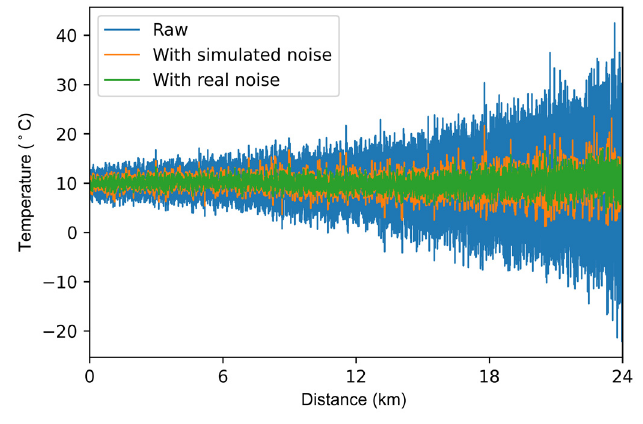
Figure 8. Temperature profile along with the fiber.